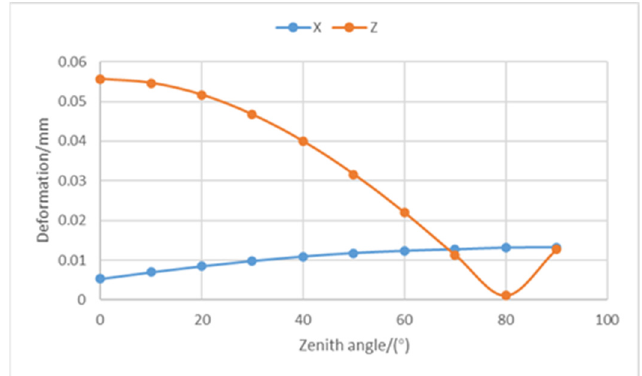
Figure 7. Deformation of the mirror chamber under gravity at different zenith angles.